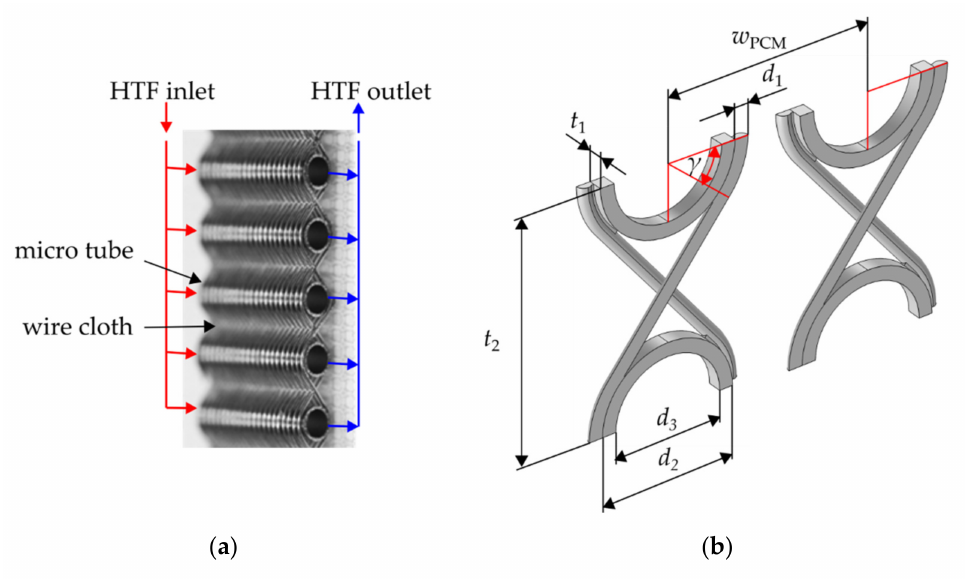
Figure 1. ( a ) Wire cloth heat exchanger; ( b ) Characteristic element of wire cloth heat exchanger. For the experimental characterization, heat exchangers with a size of 250 × 250 mm 2 were manufactured. For this contribution, we investigated a tube pitch ( t 2 ) of 5.25 mm